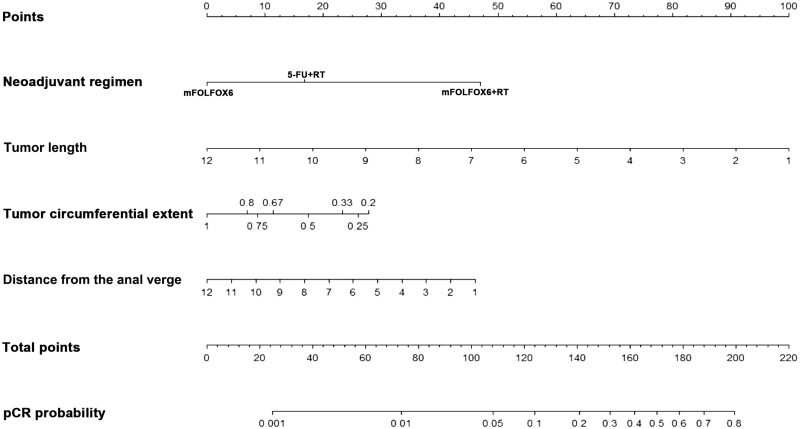
Nomogram for pathological complete response (pCR) prediction. A score for each predictor can be read out at the top scale (score). All summed scores can be converted directly to the probability of response.